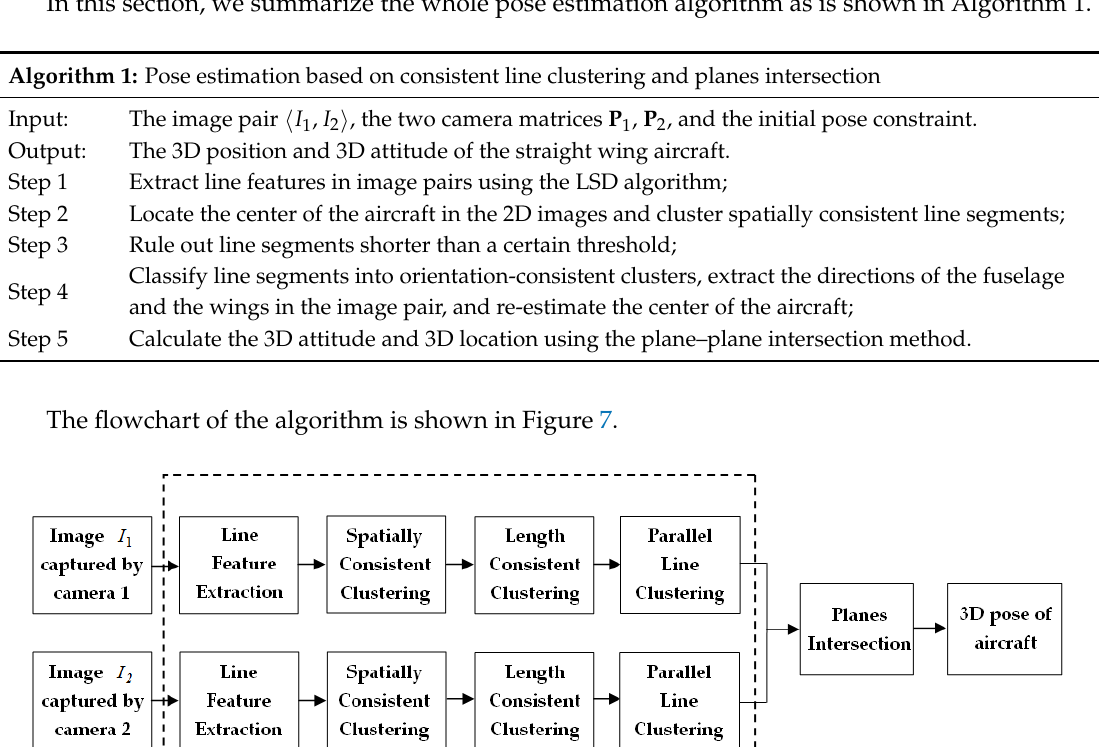
Algorithm 1: Pose estimation based on consistent line clustering and planes intersection